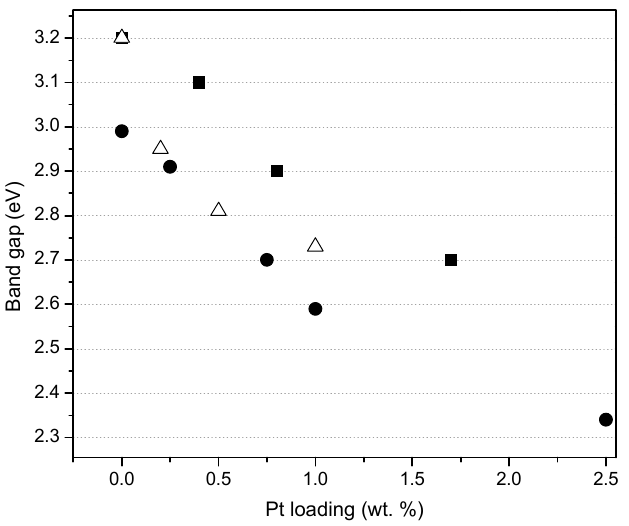
Figure 7. Influence of platinum loading on the band gap of the photocatalysts: ( ● ) TiO 2 —Mesoporous, thermally treated at 550 °C (sol-gel B) [8], ( ■ ) TiO 2 —Mesoporous, calcined 450 °C (sol-gel A), ( Δ ) Degussa P25 impregnated and calcined at 450 °C. Note: The band gap for Degussa P25 without Pt loaded was recorded at 3.20 eV.